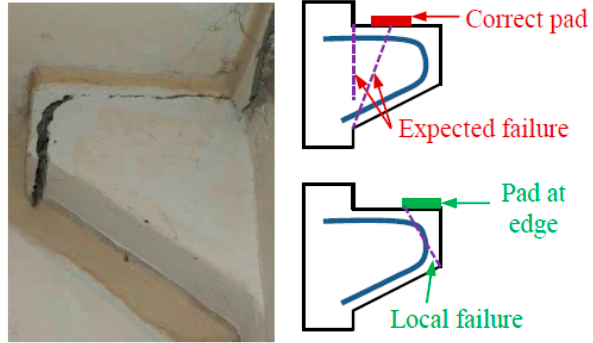
Figure 4. Spalled reinforced concrete corbel due to the inadequate position of the load bearing plate (Source: Neupane et al. [12]).